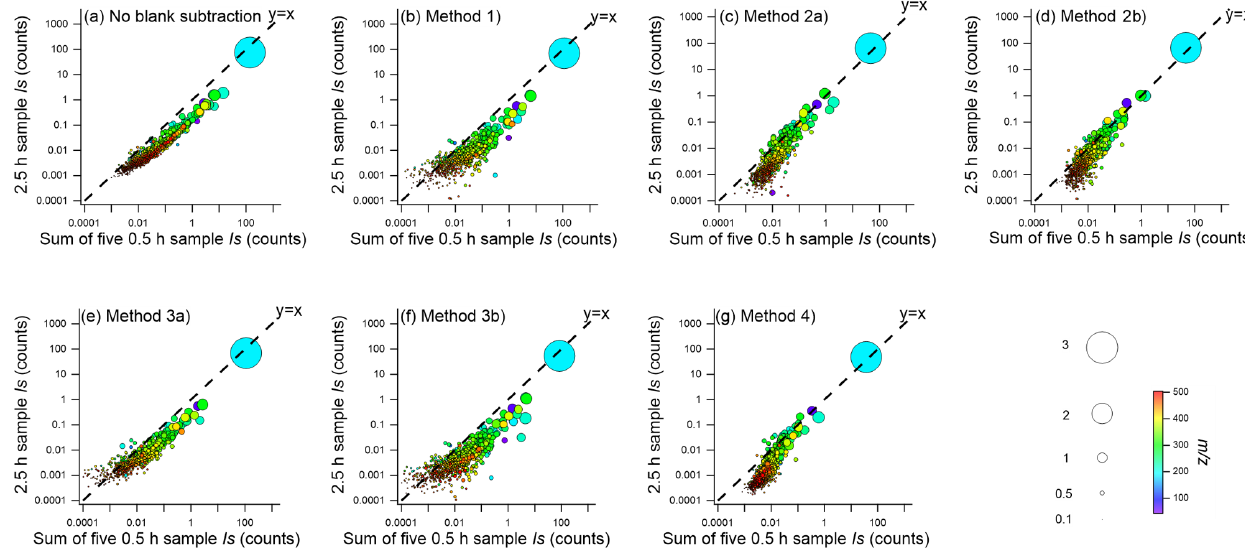
Figure 3. Comparison of the integrated signals (Is) for the 2.5h versus sum of 0.5h samples (a) without blank subtraction and with blank subtraction, using (b) Method 1, (c) Method 2a, (d) Method 2b, (e) Method 3a, (f) Method 3b, and (g) Method 4. The size of dots is proportional to the fourth root of integrated signal intensities of compounds, and they are color-coded by the m/z (mass-to-charge ratio) of the ions.